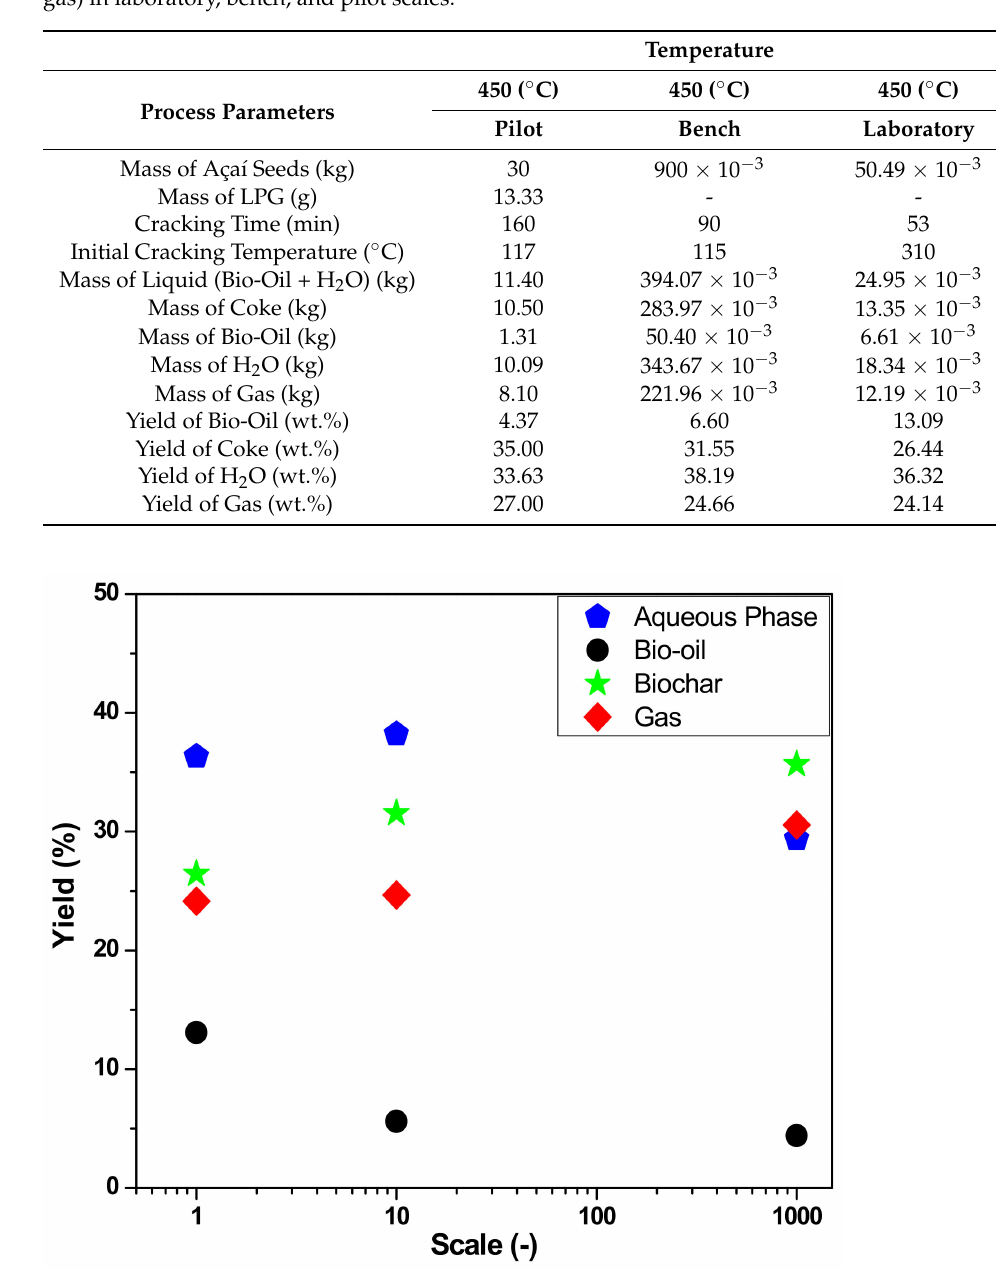
Table 2. Mass balances, process conditions, and yields of reaction products (coke, bio-oil, H 2 O, and gas) in laboratory, bench, and pilot scales.